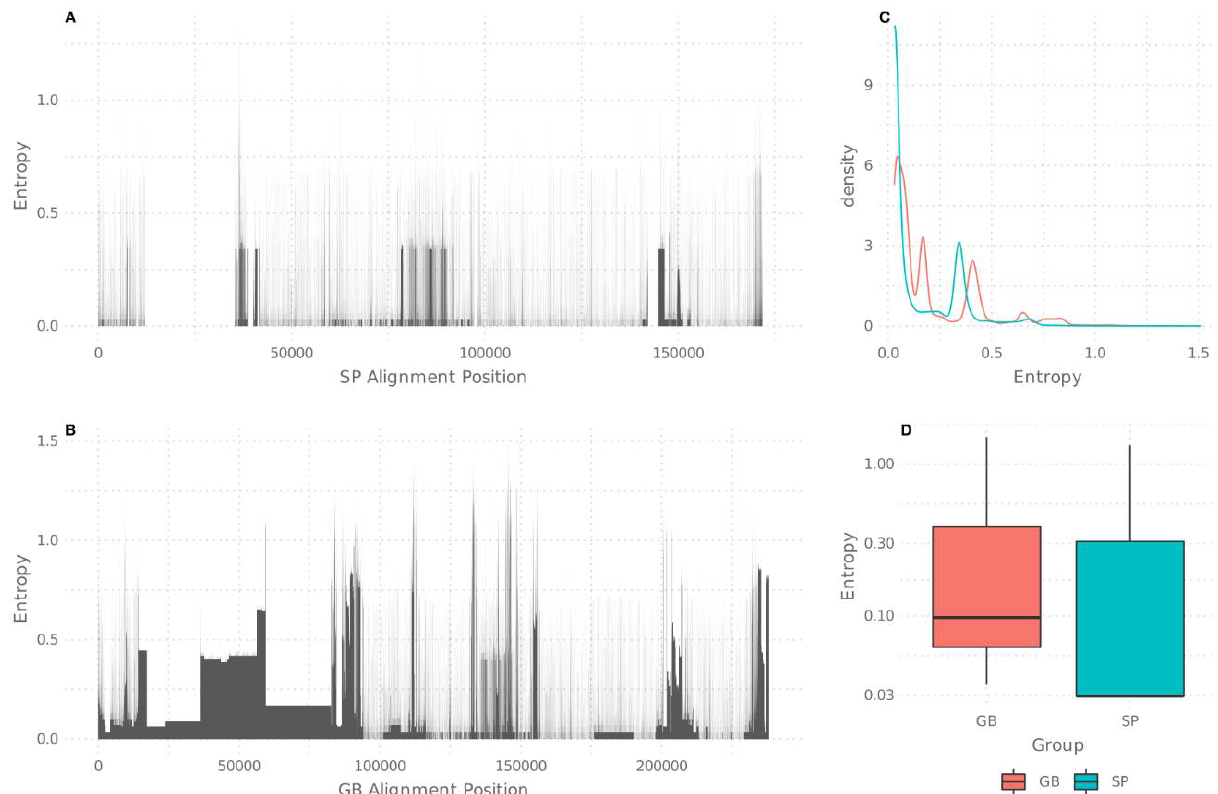
Figure 1. Alignment entropy analysis: ( A ) entropic positions in the single pipeline (SP)-generated alignment; ( B ) entropic positions in the alignment directly generated with GenBank (GB)-downloaded sequences, for which highly entropic positions are depicted as black spikes or blocks; ( C ) entropy density chart for both SP and GB alignments, considering all alignment positions; ( D ) entropy comparison considering only positions with entropy >0, depicted in box plots.